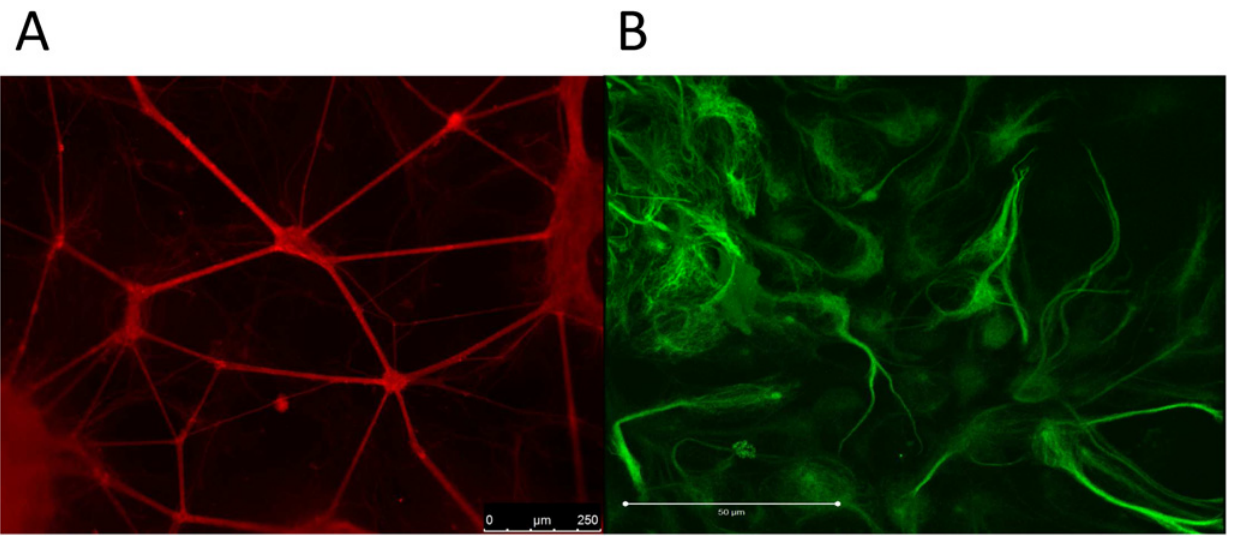
Fig 2. Immunofluorescence images of NT2 neurons and astrocytes. A) Bundles of β -tubulin III positive NT2 neurons interconnected with neurites (stained red) and B) GFAP positive NT2 astrocytes (stained green).